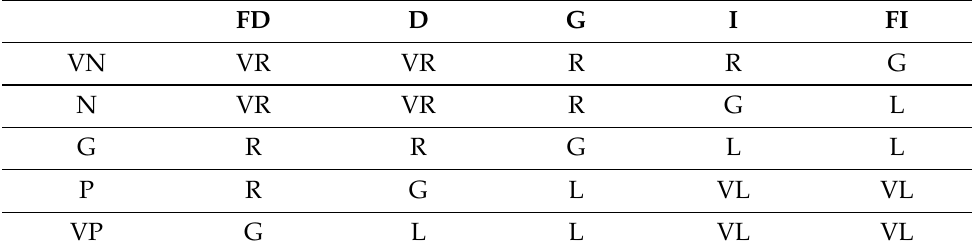
Table 2. The rules of the fuzzy logic